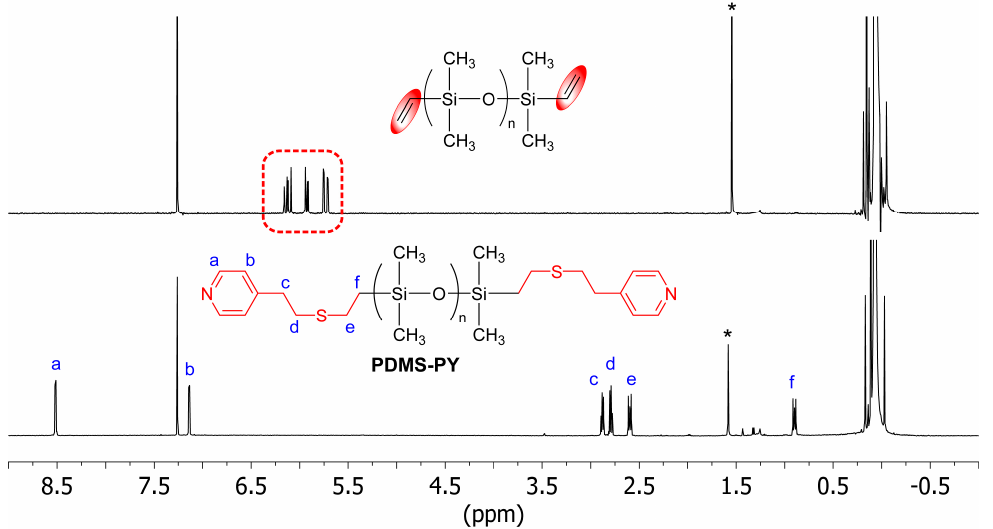
Figure 2. 1 H NMR spectra comparison (25 °C, CDCl 3 ) of a vinyl-terminated telechelic PDMS commercial sample (top), and the sample after the installation of the pyridyl end-group (PDMS-PY, bottom) via a “click” reaction. (* = H 2 O trace from “wet” CDCl 3 ).